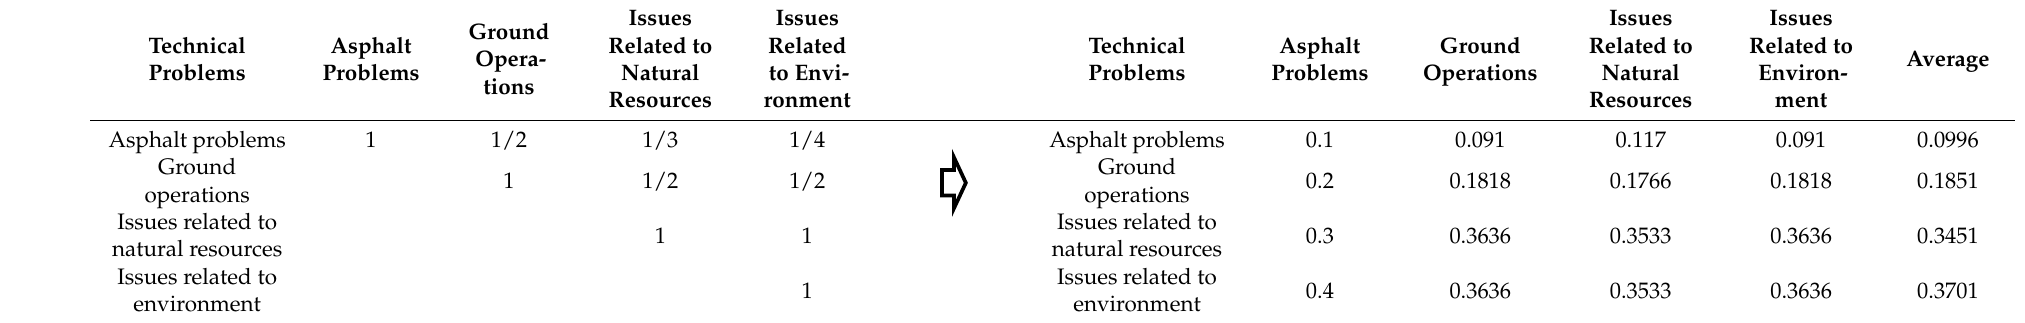
Table 5. The pairwise comparisons matrix for management problems. Table 4. The pairwise comparisons matrix for lands’ funding. Table 6. The pairwise comparisons matrix for technical problems.